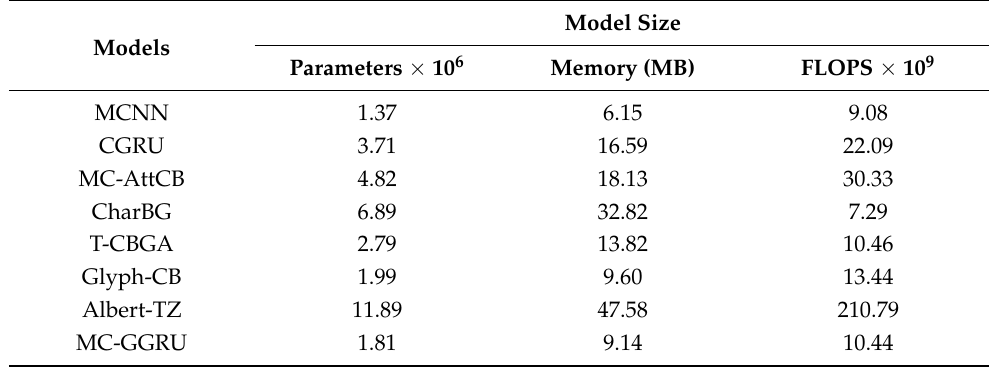
Table 3. Model statistics for each model. Each model is evaluated on the TSBH corpus. Model Size Models Parameters × 10